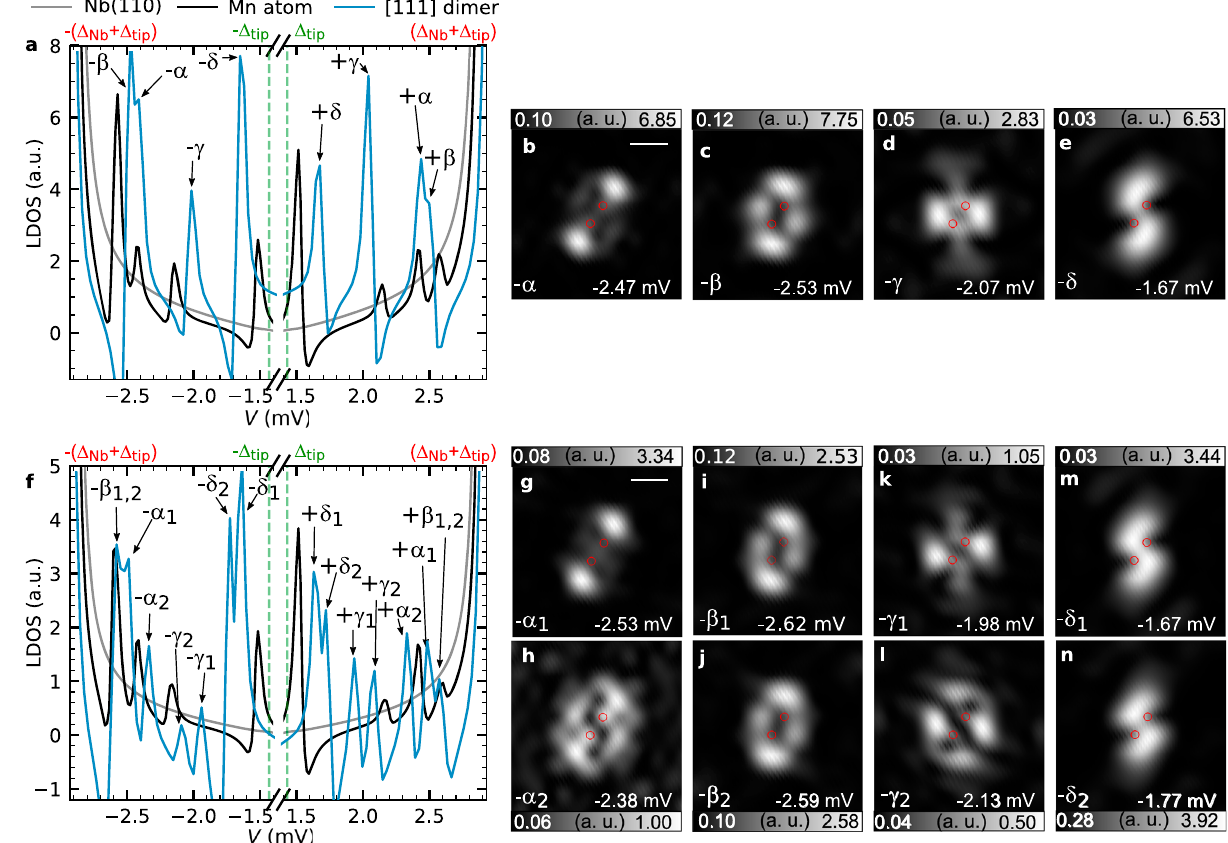
ffiffiffi p -- a = 2 (cid:3) ½ 1 Fig. 4 Calculation of hybridized Shiba states in an AFM-coupled 3 11 (cid:2) Mn dimer. LDOS inside the superconducting gap calculated between the two atoms of the out-of-plane AFM-aligned dimer (blue), for a single adatom (black) and on the bare superconductor (gray), a without and f with taking SOC into account. The spectrum is convoluted with the superconducting DOS of the tip. Shiba states are labeled and marked by arrows. Two-dimensional maps of the LDOS at the indicated bias voltages show the spatial pro fi les of the states without ( b – e ) and with ( g – n ) SOC. Red circles denote the positions of the adatoms in the dimer. The white scale bar has a length of 500 pm. The crystallographic axes are the same as in Fig. 3b. Magnetic and non-magnetic scattering parameters with and without SOC are given in Supplementary Tables 1 and 2,